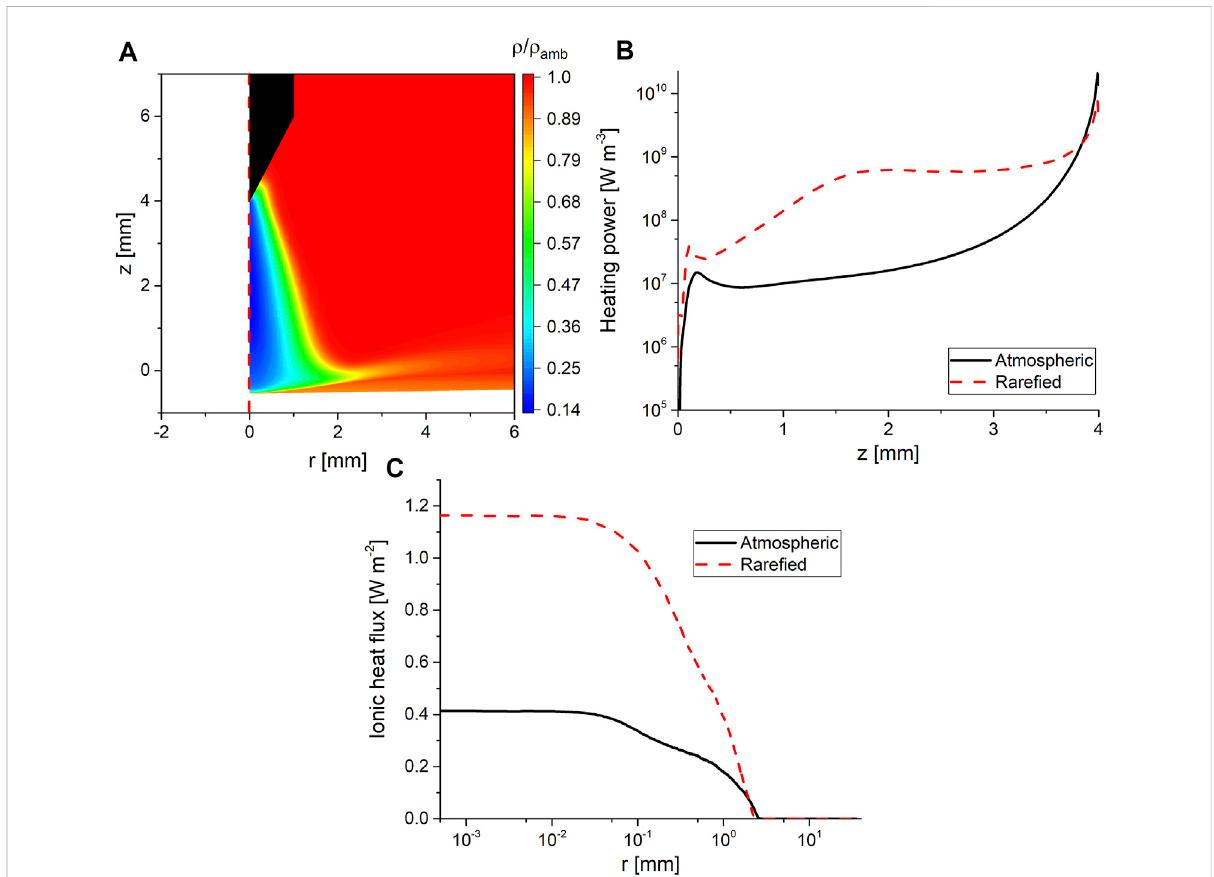
FIGURE 5 (A) Two-dimensional color map showing the density of the background gas normalized to its value at ambient conditions, (B) plasma power dissipatedasheattothebackgroundgasalongthesymmetryaxiswithandwithoutgasrarefactionconsidered,z=4isthetipofthepinelectrodeand z=0istheinterface,and (C) thetime-averagedionicheat fl uxestotheinterfacewithandwithoutgasrarefaction.Thedatashowninallpanelsofthe fi gure are for an operating power of 15